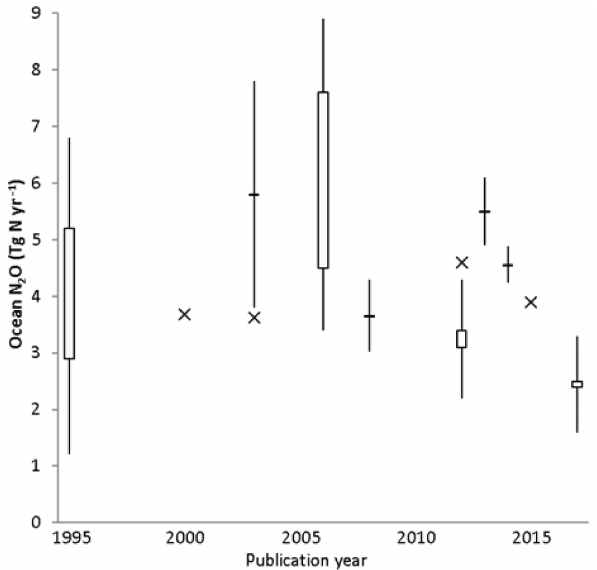
Figure 4. Published estimates of global ocean N 2 O production or air–sea exchange. Estimates based on global observational